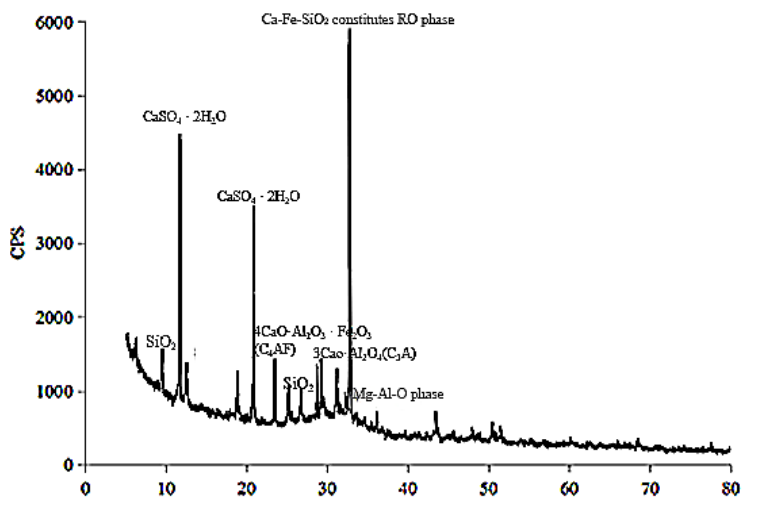
Figure 3. XRD phase analysis of cementitious material.